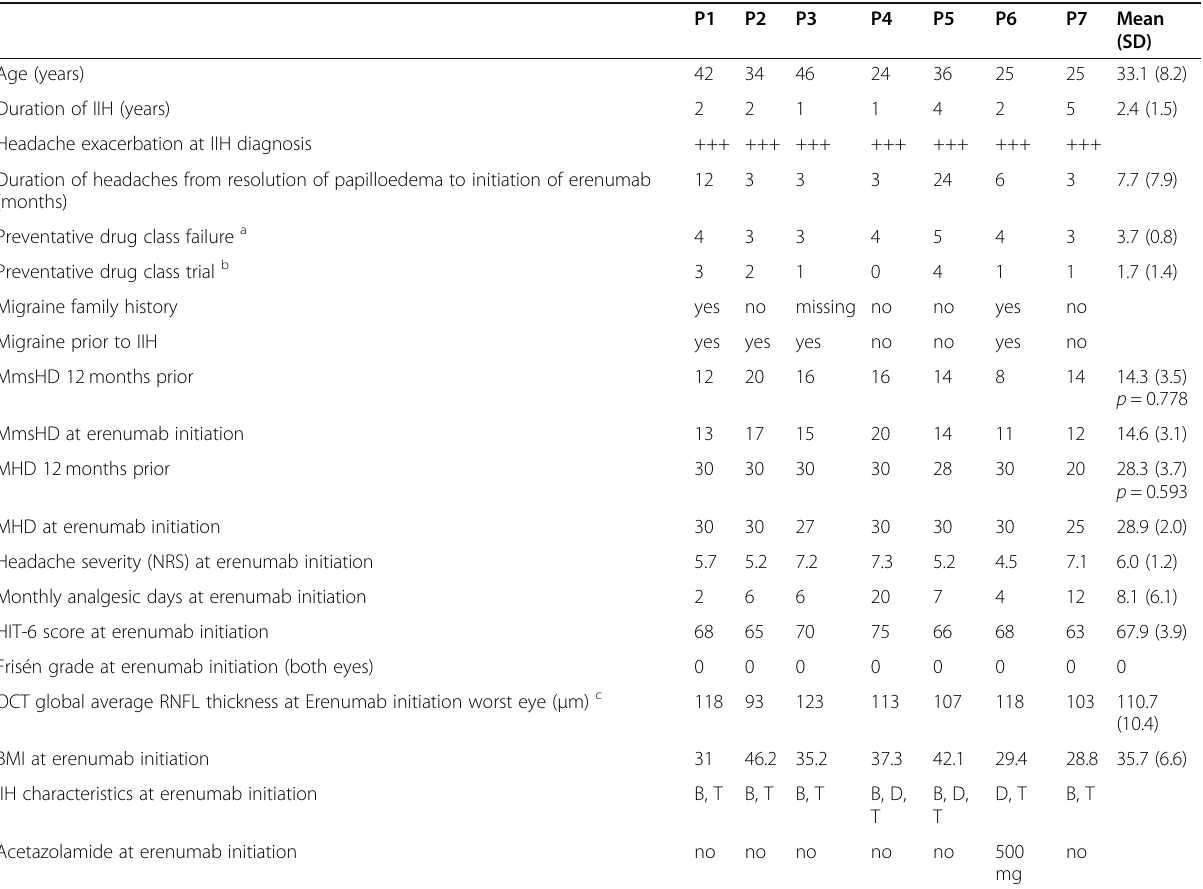
Table 1 Patient characteristics at erenumab initiation